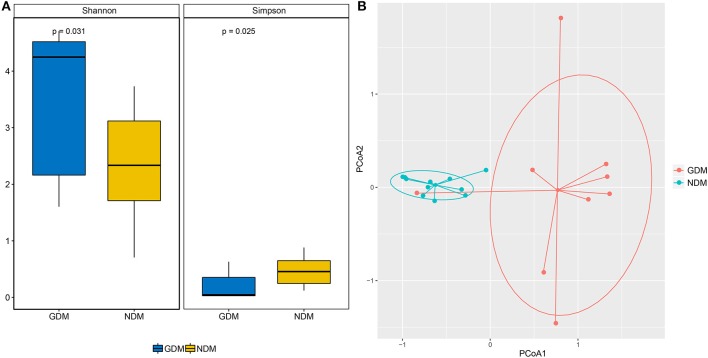
Comparison of the microbiome biodiversity between GDM and NDM groups. (A) The Shannon index, Simpson index were shown as estimators to demonstrate the difference of alpha diversity between the two groups. (B) Principal coordinate analysis plot based on the abundance and diverse in neonatal oral microbiomes between the two groups. Each point represents the oral microbiota of a newborn.